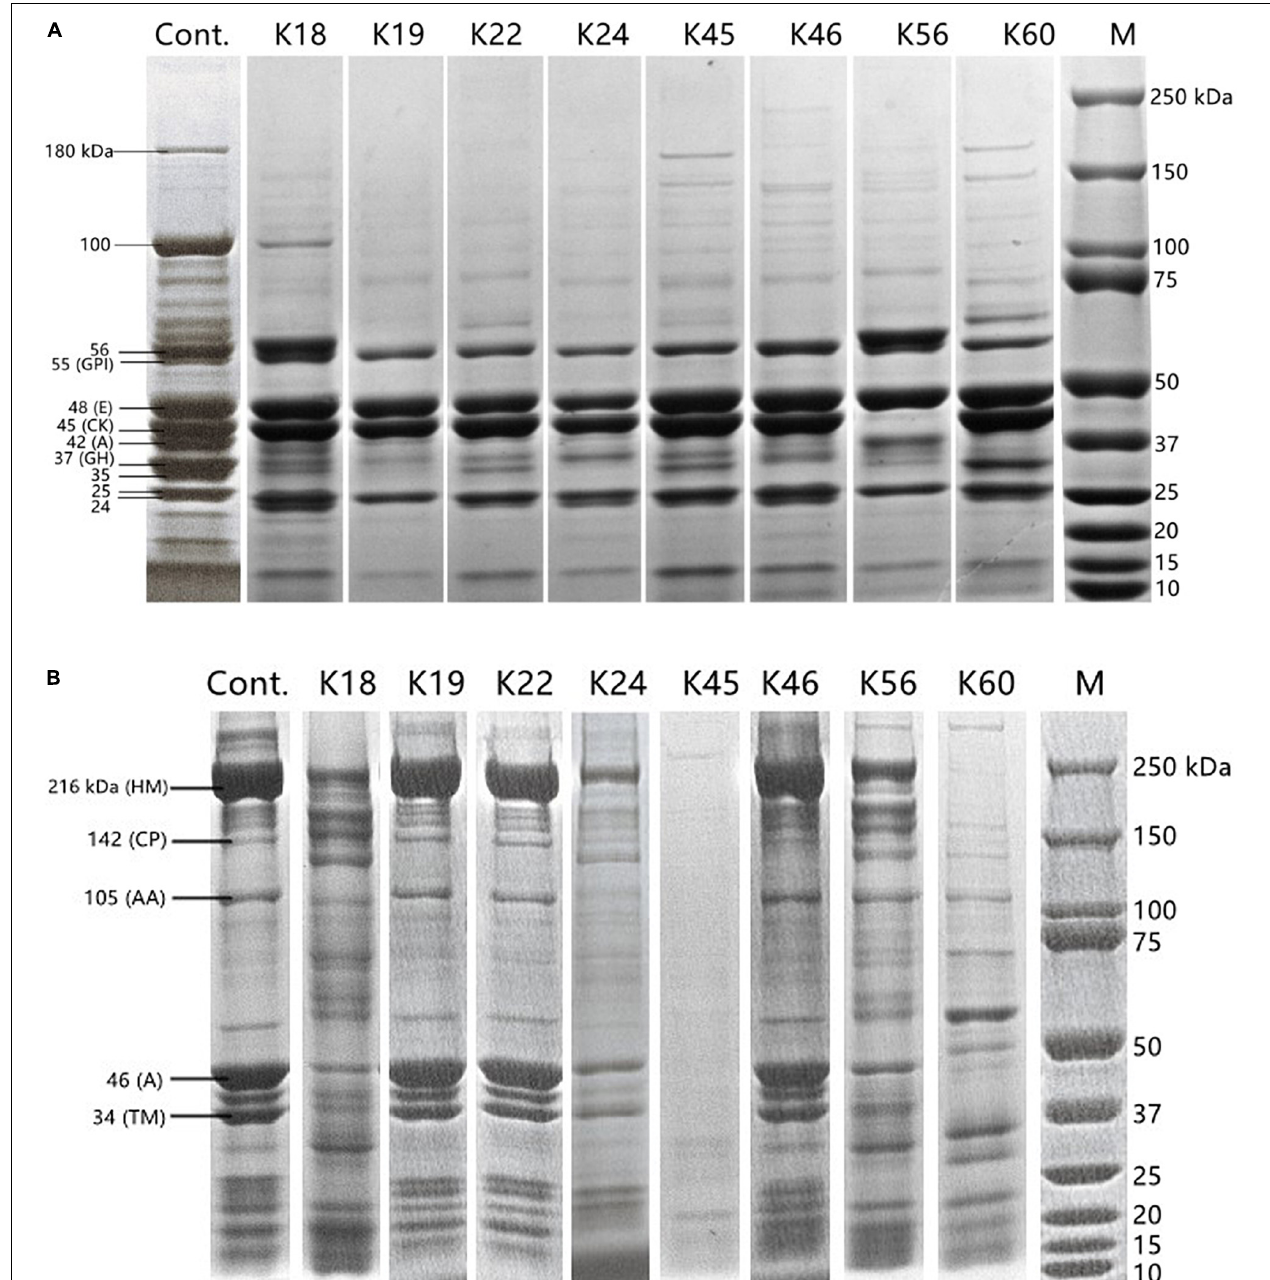
FIGURE 2 | SDS-PAGE polypeptide profile of sarcoplasmic protein (A) and myofibrillar protein (B) inoculated with the Kocuria isolates and uninoculated control. Labels in panel (A) : GPI, glucose phosphate isomerase; E, enolase; CK, creatine phosphate kinase; A, aldolase; GH, glyceraldehyde phosphate dehydrogenase. Labels in (B) : HM, H-meromyosin; CP, C protein; AA, α -actinin; A, actin; TM,